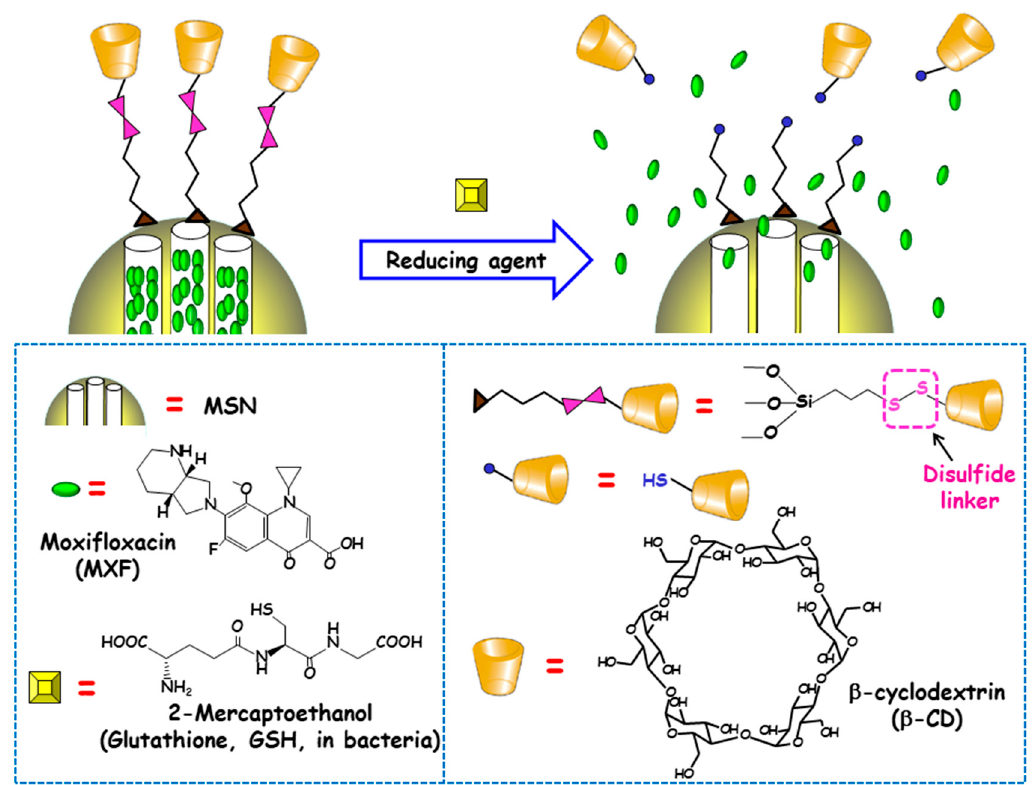
Figure 7. Schematic depiction of the operating mechanism of redox-responsive antimicrobial nanosystems consisting of disulfide modified MSNs loaded with moxifloxacin (MXF) and end-capped with β -cyclodextrin ( β -CD) throughout a disulfide linker. Adapted from ref. [91]. The exposition to reducing milieu in bacteria (e.g. glutathione or 2-mercaptoethanol) triggers the cleavage of disulfide bond, which allows pore uncapping and cargo